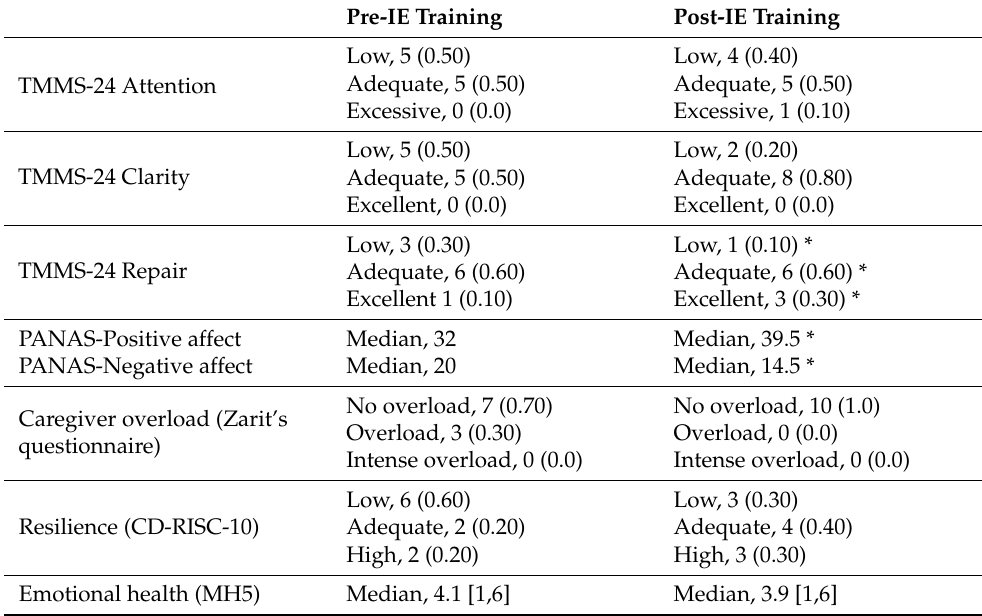
Table 2. Basal emotional status of caregivers and changes after the IE treatment.